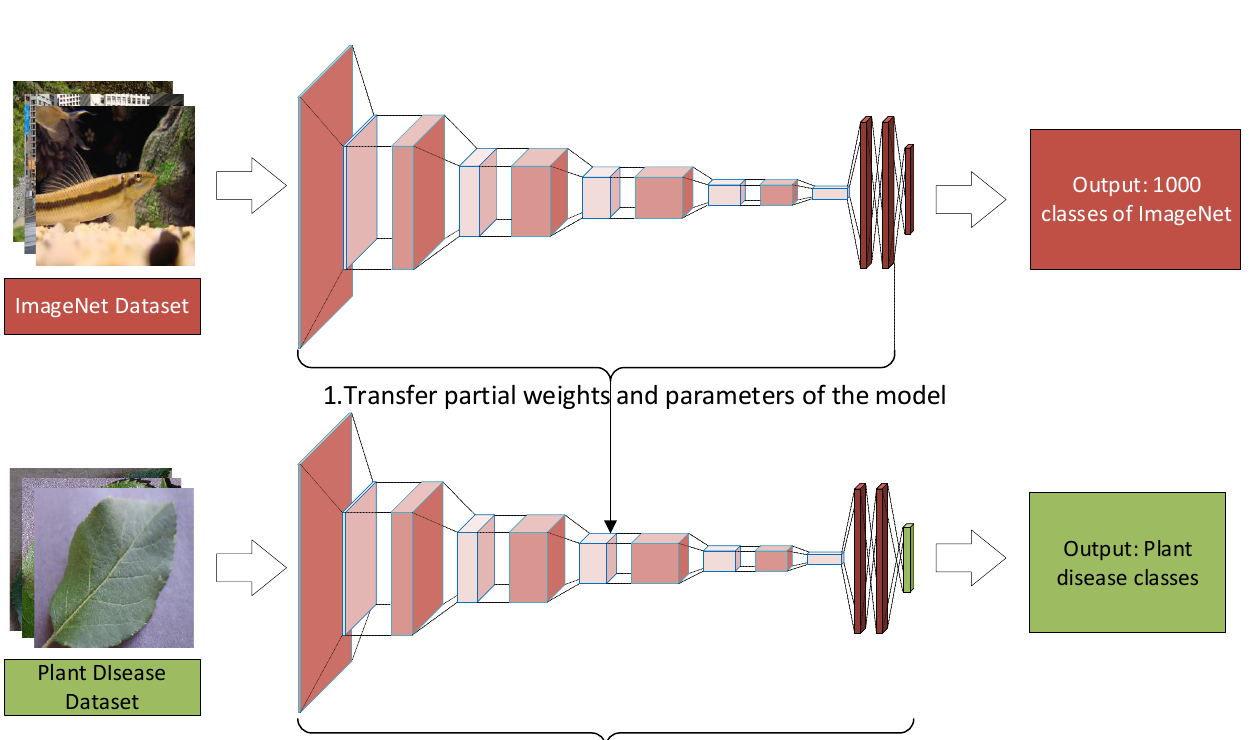
Figure 1. Architecture of a DL-based plant disease identification